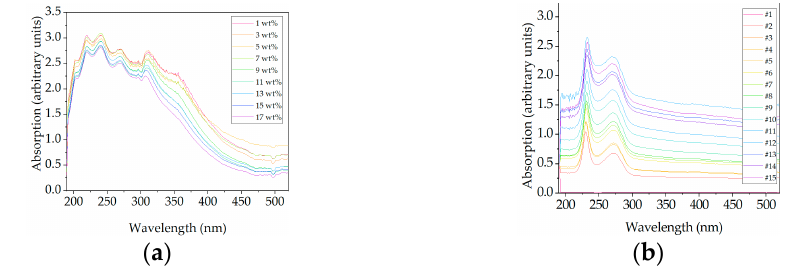
Figure 12. Spectral raw data of DAD for precipitation ( a ) and dissolution ( b ).